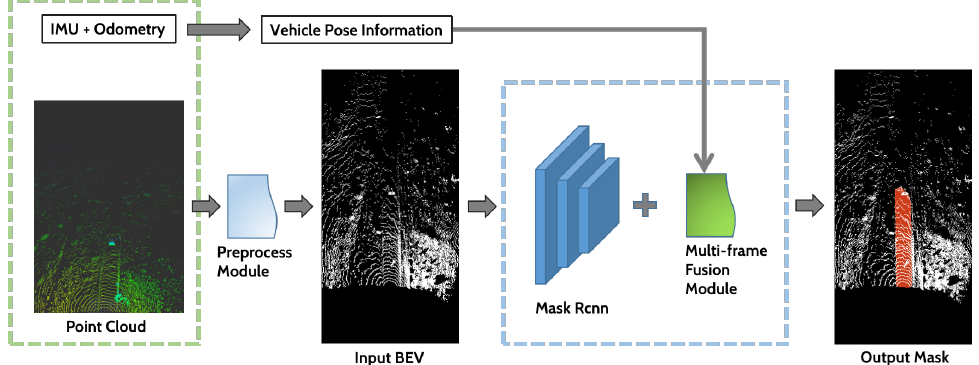
Figure 2. Algorithm framework. The input data are 3D point cloud, IMU data, and odometry information; through the preprocess module and some algorithms, the BEV of the point cloud and the pose of UGV are obtained; finally, the mask of the drivable area is obtained through the mask RCNN [52] network and multi-frame fusion module.